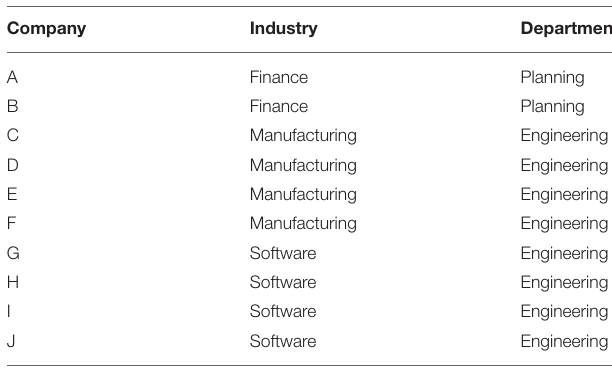
TABLE 2 | Research